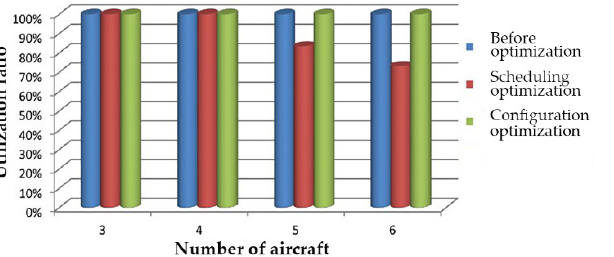
Figure 13. The relationship between the average utilization of refueling trucks and the number of aircraft.